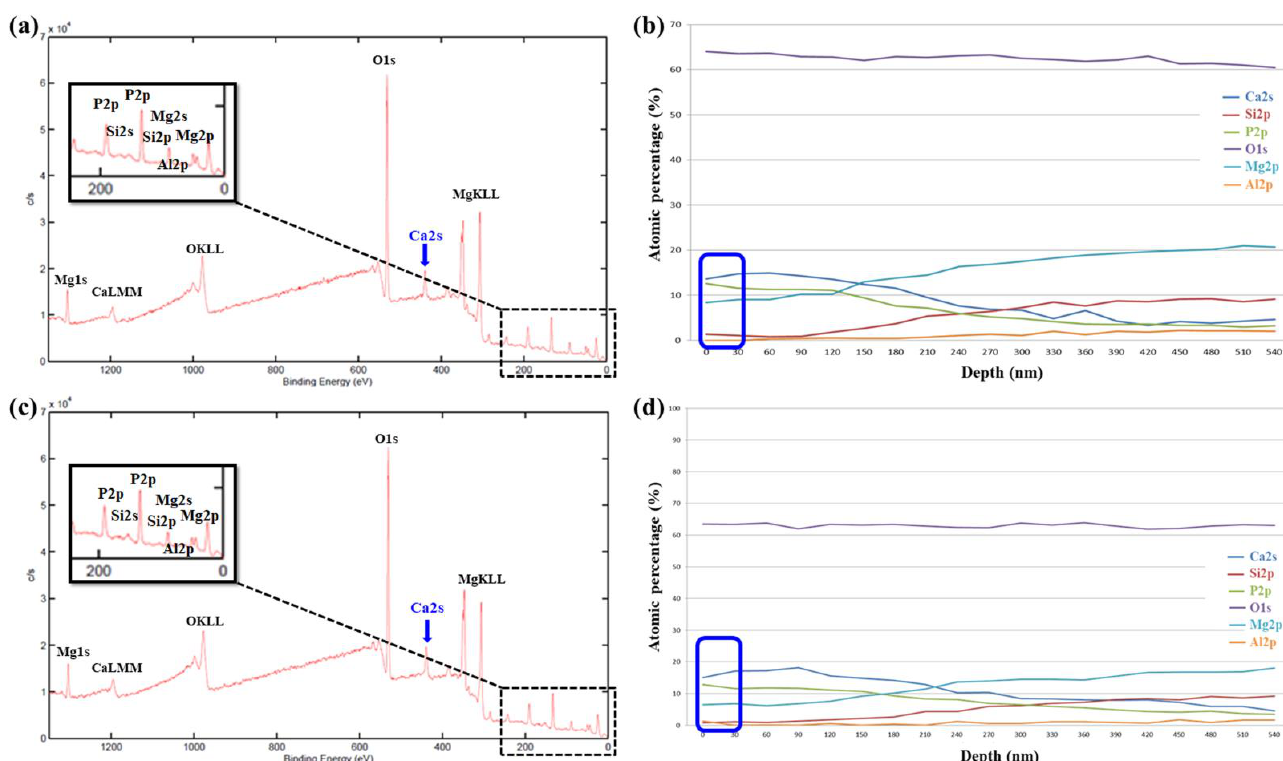
Figure 10. After 48 h immersion in the SBF solution, the XPS surface full spectrum and depth profile of the AZ31 sample treated in the EDTA ( a , b ) 0 g and ( c , d ) 7.5 g bath. Table 6. Content of Ca and P elements of MAO coated sample.